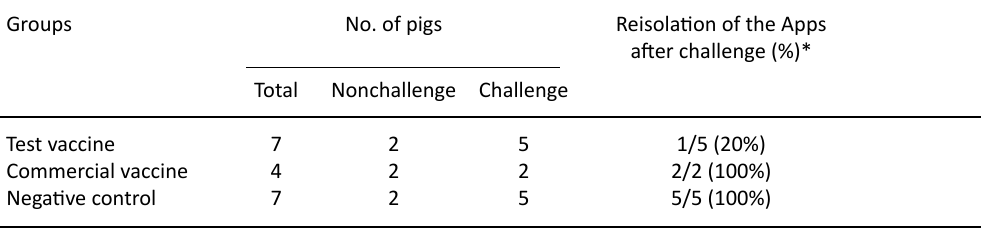
Table 2. Animal experimental design and reisolation of challenge Apps